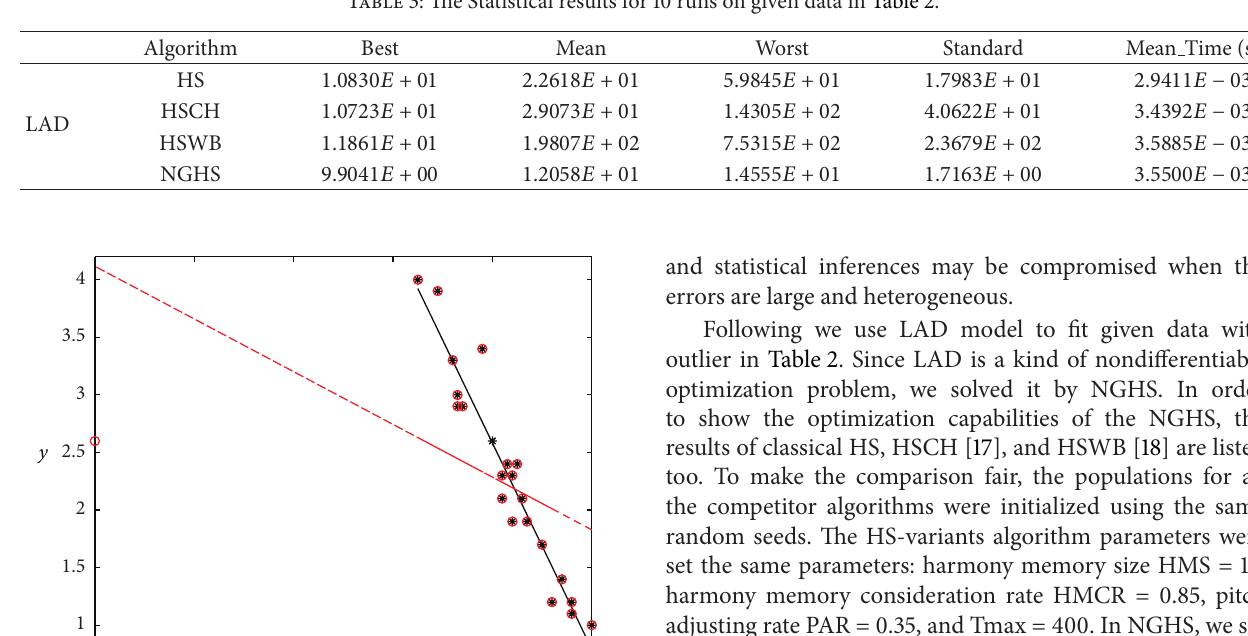
Table 3: The Statistical results for 10 runs on given data in Table 2.